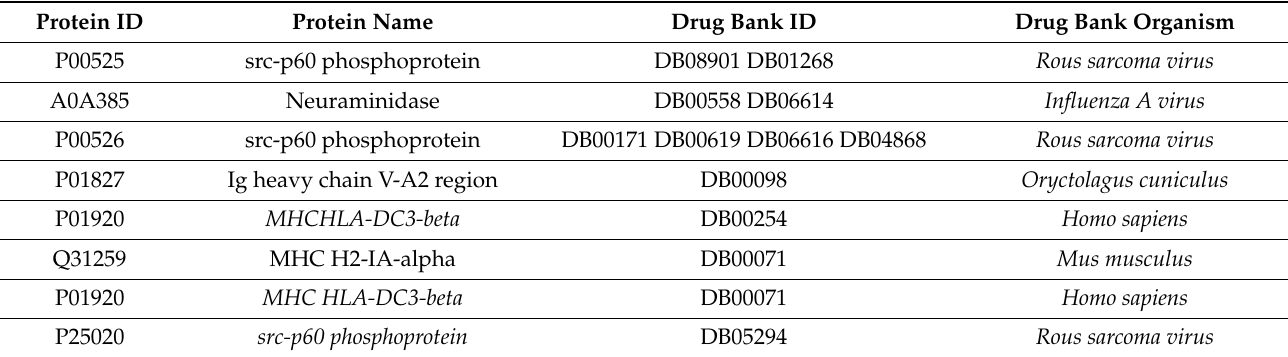
Table 2. Non-similar vital proteins of B. pertussis strain B1917 similar to FDA-approved drugs against database of DrugBank using BLAST P.